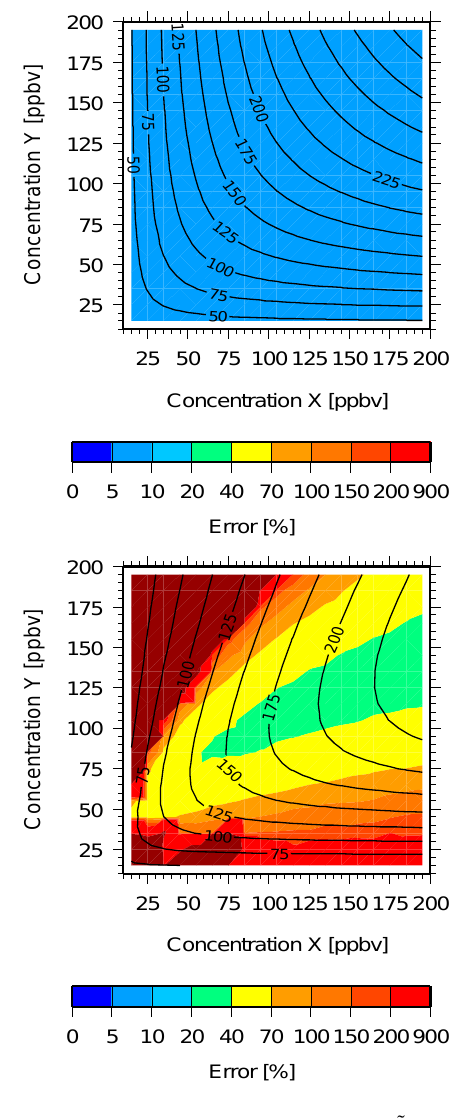
Fig. 8. Standard deviation of the error E (top) and ˜ E (bottom) [%]. Overlaid are the contour lines of the values of Z and ˜ Z , respectively.